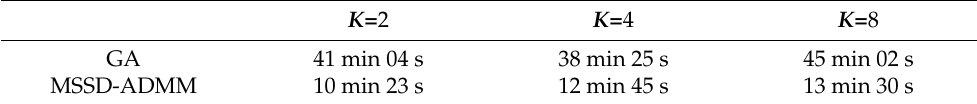
Figure 5. Comparison of convergence curve between MSSD–ADMM and GA. Table 7. Comparison of optimization time between MSSD-ADMM and